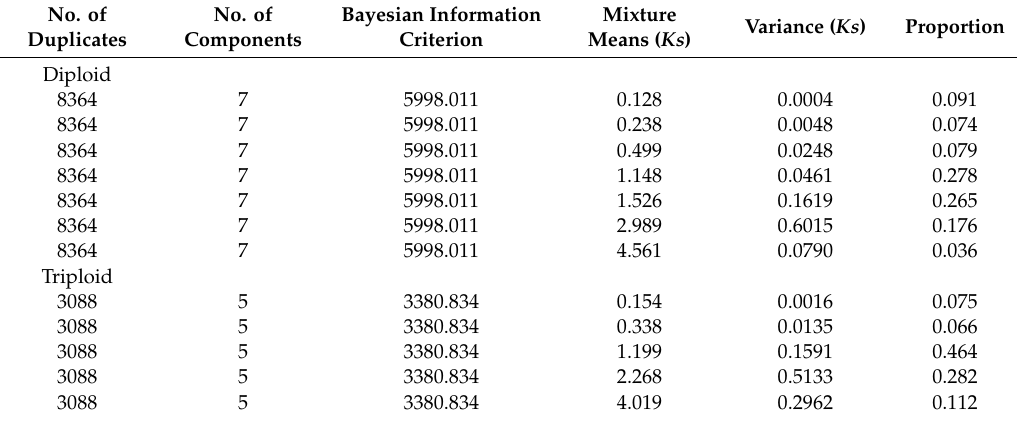
Figure 2. Frequency distributions of Ks values based on paralogous pairs of C. thalictroides . ( A , C ) Distributions of Ks values pairs of the diploid and triploid within 5. The x-axis represents the synonymous substitutions with a Ks cuto ff of five in bins of 0.1, and the y-axis shows the number of retained duplicated paralogous gene pairs. ( B , D ) Mclust Gaussian mixture model analysis of ( A , C ), respectively. Optimal number of log-normal components overlaid on Ks distributions. The red line shows the sum of components. Table 3. Mixture modeling of the age distribution of C. thalictroides presented in Figure